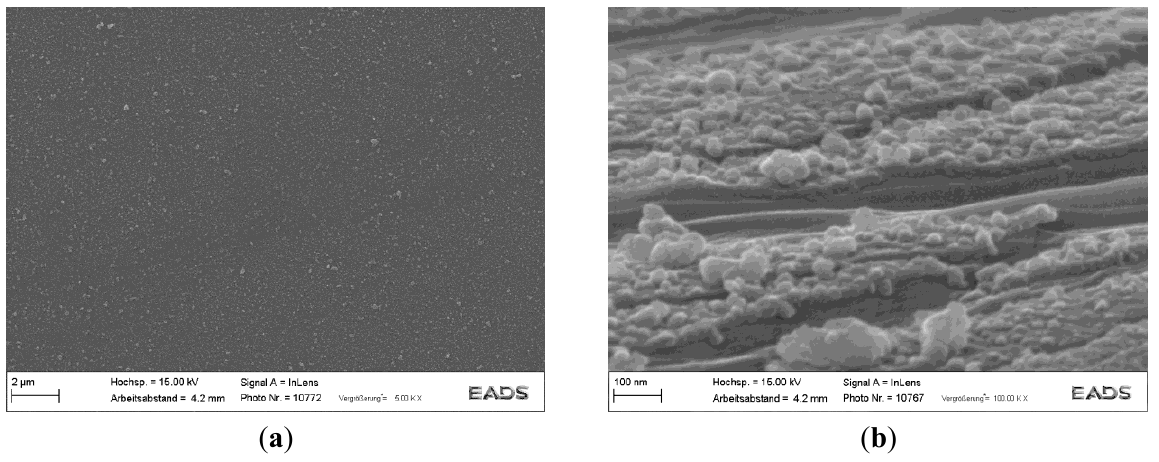
Figure 3. SEM micrographs after film deposition on Ti 15 V 3 Cr 3 Sn 3 Al ( a ) top view; ( b ) Cryo fracture of Ti 15 V 3 Cr 3 Sn 3